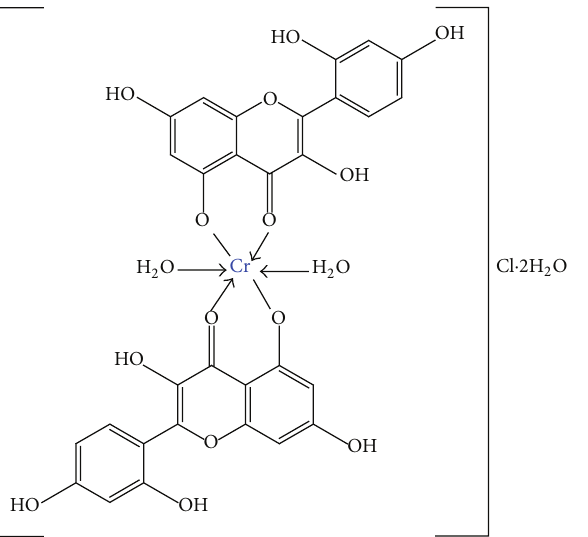
Scheme 2: The addition of sample compound to the DPPH ∙ may change its color from violet to yellow (also shown as cuvettes) because the proton from the sample is transferred to DPPH ∙ by converting it into corresponding hydrazine form.